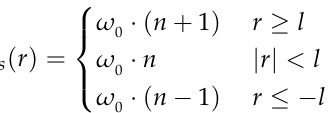
Figure 3. The actuator dead zone in speed regulation.